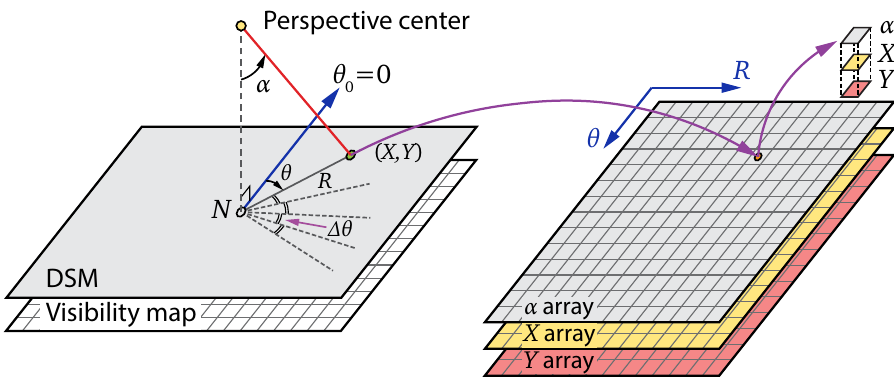
Figure 8. Principle of the radial sweep method for angle-based occlusion detection.